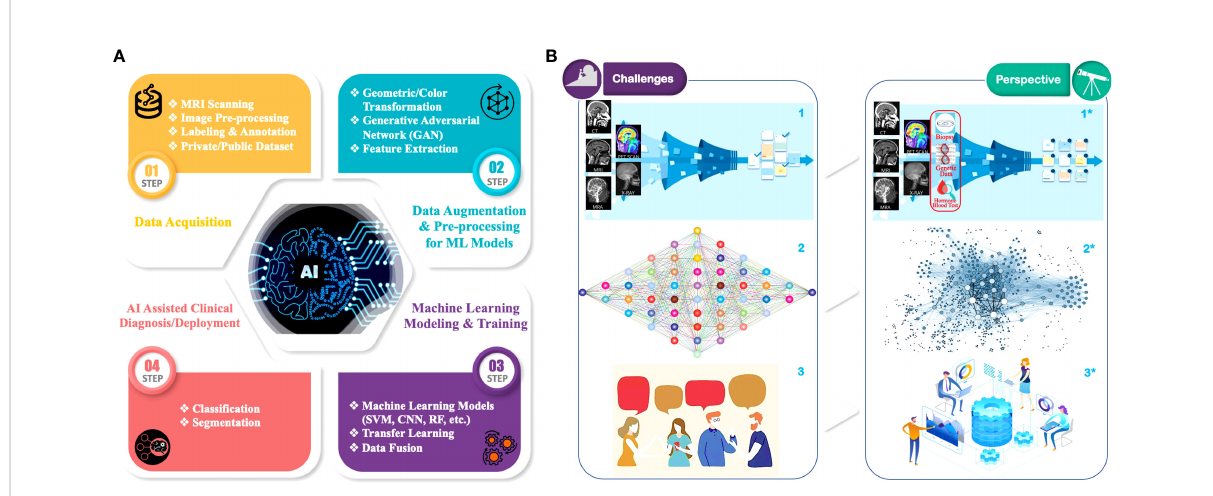
FIGURE 1 AI/ML in GBM radiomic analysis: (A) Overall work fl ow of AI-assisted GBM analysis: 1) Data Acquisition . Raw radiological image data are acquired by MRI scanning of GBM patients. Images are collected into public or private data sets. Before analysis, images are preprocessed (e.g., data cleaning, co-registration, normalization) and standardized (e.g., format, resolutions, voxel sizes). Then, radiologists annotate the images, color- coding different parts of the tumor habitat. 2) Data Augmentation and Preprocessing for ML Models . Imaging dataset and its annotations from step 1 are further “ augmented ” via geometric transformations, photometric transformation, and/or synthetic data (e.g., GAN) to improve the data generalizability, followed by the optional preprocessing for ML modeling, a process that includes feature extraction to fi lter out “ useless ” data and extract explicit features (e.g., biological and/or geometry) in the images. 3) ML modeling and training . Augmented and preprocessed data are fed into various ML models (e.g., SVM, RF, CNN) for GBM radiomic analysis training and validation. Advanced techniques such as transfer learning and multimodal data fusion (e.g., clinical and genomic data) can be employed to improve the training accuracy as well as generality. 4) AI-Assisted Clinical Diagnosis/Deployment . Predictions from the ML models for various medical demands, such as differential diagnosis and survival estimation. (B) Current major challenges (left panel: 1, 2, 3) and perspectives for corresponding solutions (right panel: 1*, 2*, 3*) in AI/ ML-assisted GBM radiomic analysis: 1 → 1* Current GBM radiological image datasets are limited in low numbers, insuf fi cient annotations, and poor organization. Enrichment and standardization of current GBM radiological datasets are urgently needed, while incorporation of clinical and/or genomic data (red circle) can further enhance the performance of ML prediction models; 2 → 2* develop more comprehensive ML models to further improve the prediction accuracy and address the relatively low generalizability of current models; 3 → 3* further strengthen collaborations among clinicians, biomedical researchers, and computer scientists to overcome the lack of ef fi cient communications between these parties for the highly multidisciplinary